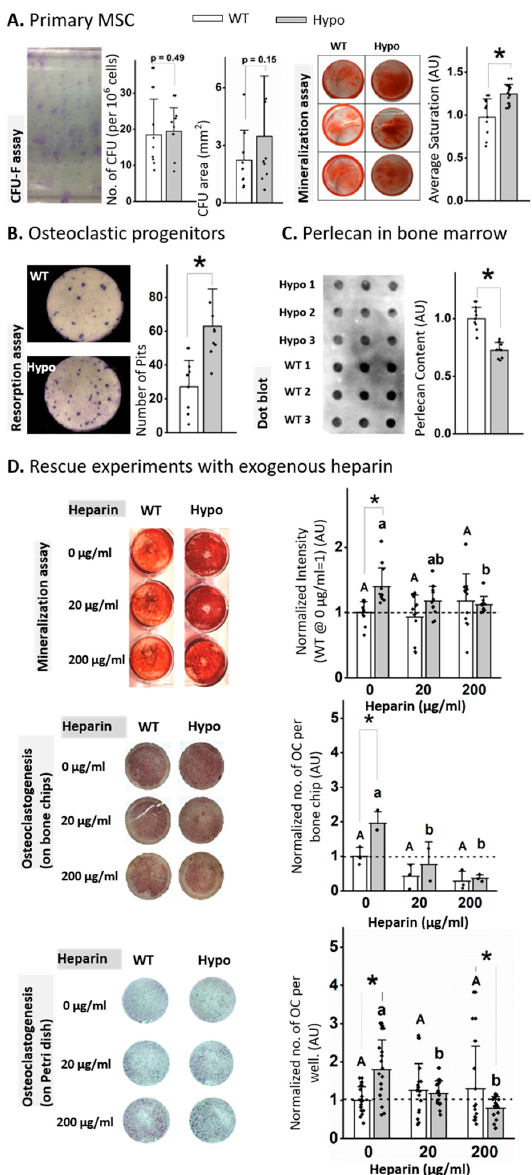
Figure 2. Perlecan deficiency altered MSC differentiation, but not proliferation ( A ), and increased osteoclastogenesis and resorptive activity ( B ). Perlecan content was reduced in Hypo marrow ( C ). Treating the primary MSC and osteoclast progenitor cells with exogenous heparin rescued the effects from the perlecan deficiency ( D ). Significance for within-genotype dose comparisons are indicated by different letters (uppercase for WT and lowercase for Hypo) and between-genotype comparisons indicated by * ( p < 0.05). Open bars: WT; filled bars: Hypo.